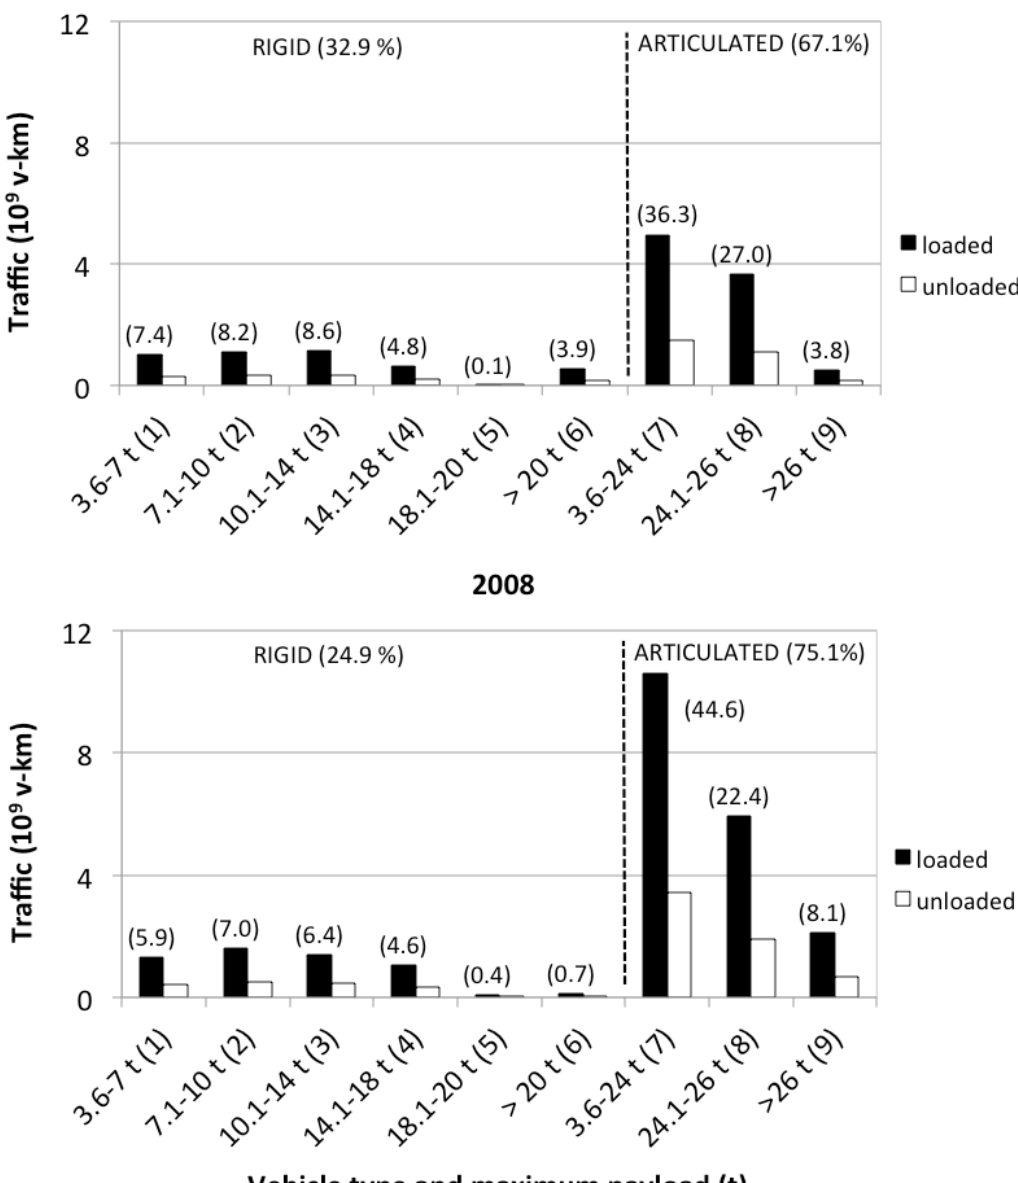
Figure 1. Distribution of v-km by type of vehicle and payload. Note: traffic shares of laden kilometres in brackets; 1 equivalent to <10 t Gross Vehicle Weight (GVW); 2 10-13.5 t; 3 14.1-18 t; 4 18-24 t; 5 24.1-26 t; 6 >26 t; 7 10-32 t (GVW); 8 32.1-38 t; 9 38.1-44 t; Source: (MFO,